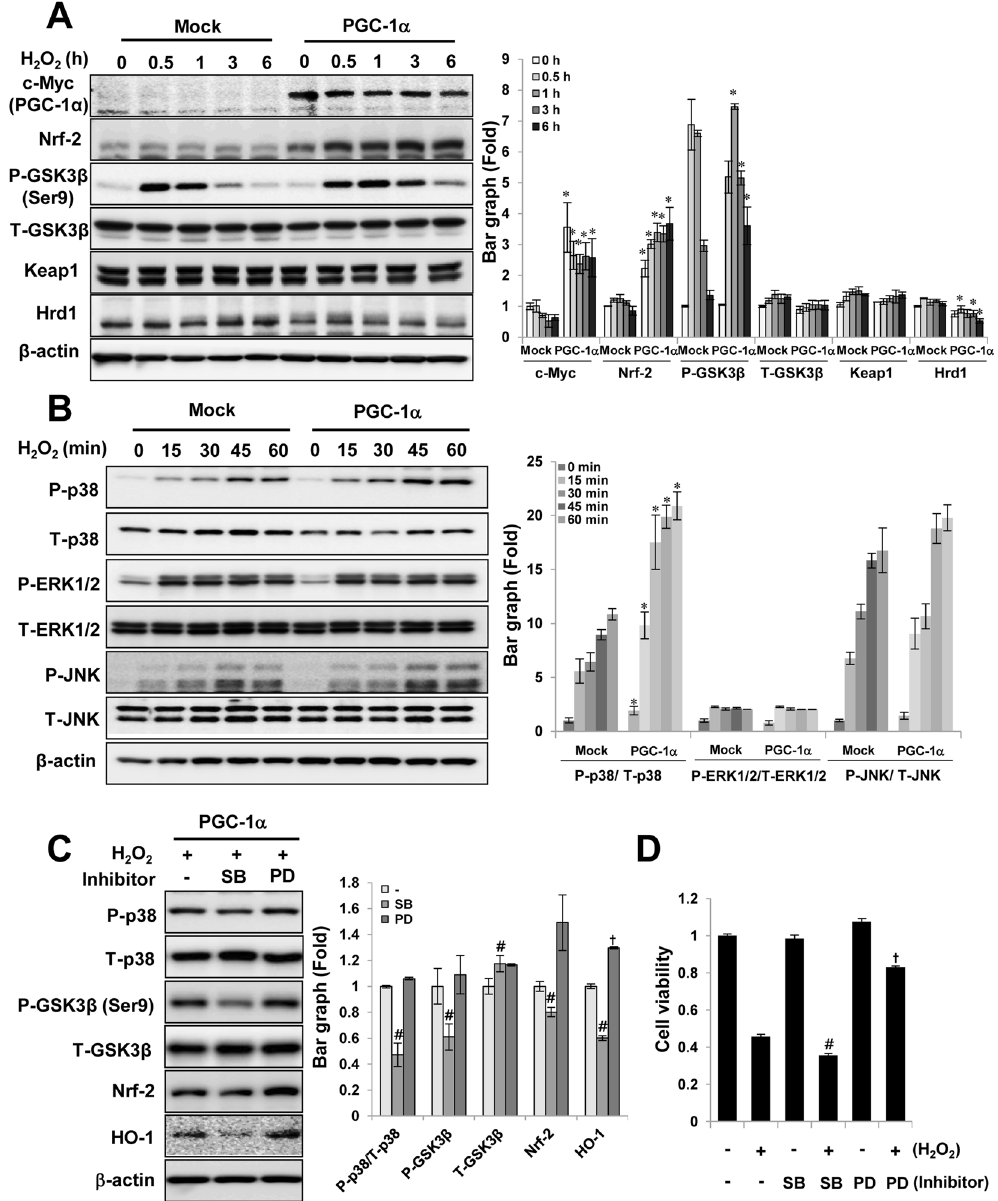
Figure 8. The involvement of p38/GSK3 β /Nrf-2 axis for cytoprotective effects of PGC-1 α . To understand the molecular mechanism for cytoprotective effects of PGC-1 α , the activation of Keap1-, GSK3 β - or Hrd1 ( A ) and MAPKs ( B ), as an upstream signal molecules of Nrf-2, were compared to Mock and PGC-1 α cells for indicated time points after H 2 O 2 treatment. To further elucidate the specificity of p38-mediated signal cascade for cytoprotective effects of PGC-1 α cells, p38 specific effects were analyzed by western blotting ( C ) and MTT assay ( D ) in PGC-1 α cells treated with H 2 O 2 in the presence or absence of p38 inhibitor (SB203580) for 2 h or 4 h, respectively. Inhibitor of ERK1/2 (PD98059) was used as non-effective control on PGC-1 α effect. Activation of p38 or inactivation of GSK3 β was checked with phosphor specific antibody at Thr180/Tyr182 residue or at Ser9 residue, respectively. Full-length blots of each tested protein are reported in Supplementary Figure S7. Error bars denote the mean ± S.D. of triplicate samples. MTT assay was performed to n = 7. * p < 0.05 H 2 O 2 -untreated Mock vs. PGC-1 α at indicated time points; # p < 0.05; p38 inhibitor treated vs. untreated; † p < 0.05; ERK1/2 inhibitor treated vs.